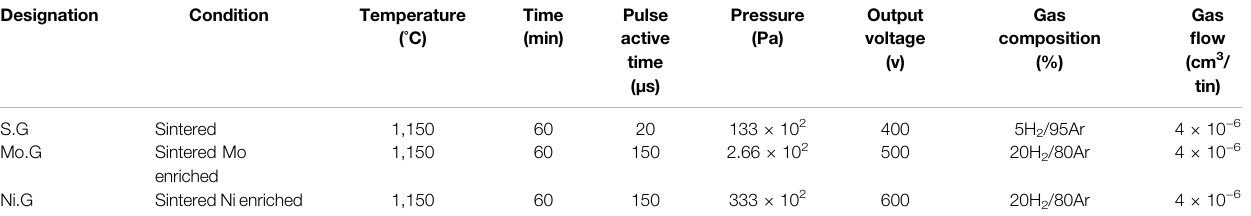
TABLE 3 | Parameters of the sintering and surface enrichment processes.